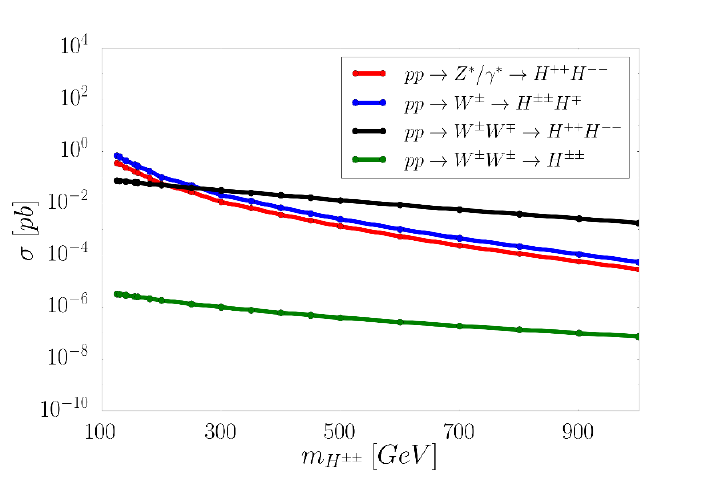
Figure 1 . Production cross section for the dominant production channels at the LHC with p s = 13 TeV, the example values (cid:29) T = 0 : 1 GeV for the triplet Higgs vev and (cid:21) 0